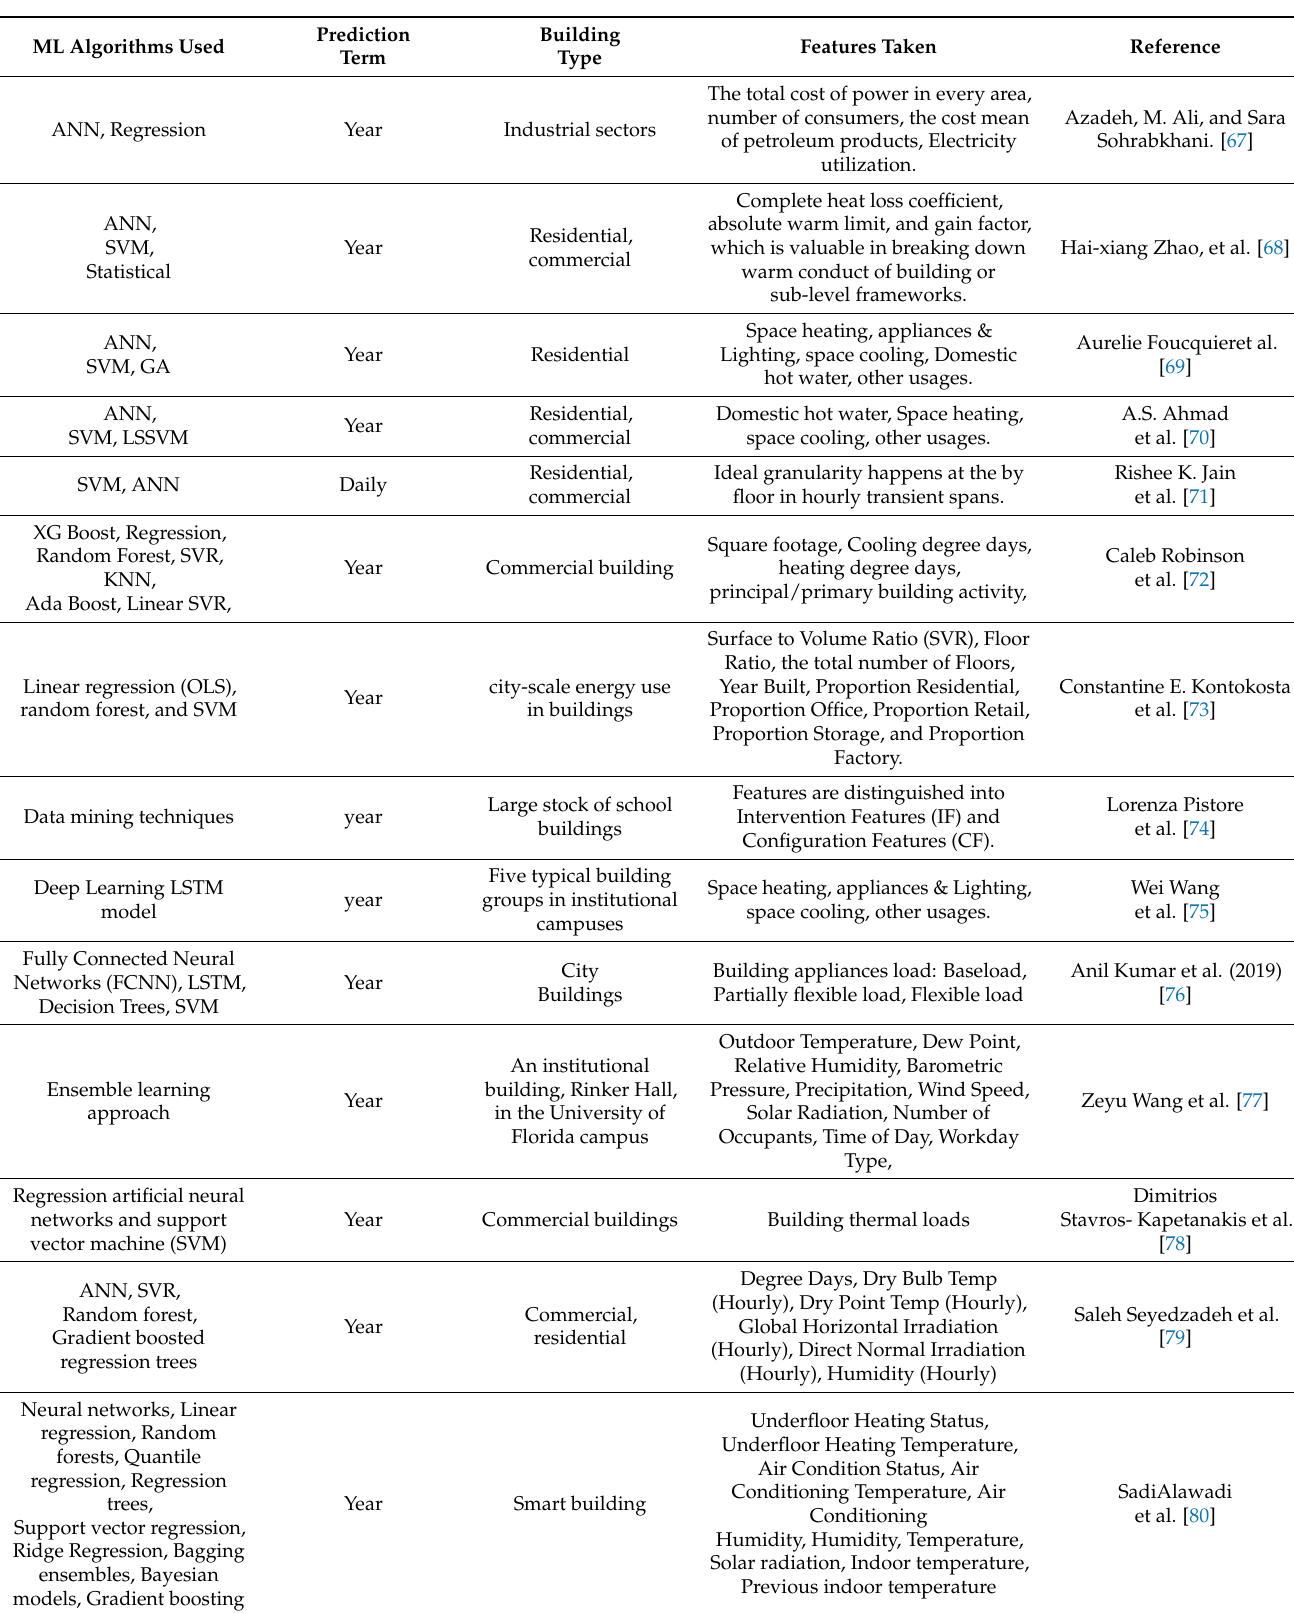
Table 8. Outline ofthe computational machine learning methods for the analysis of building energy utilization and